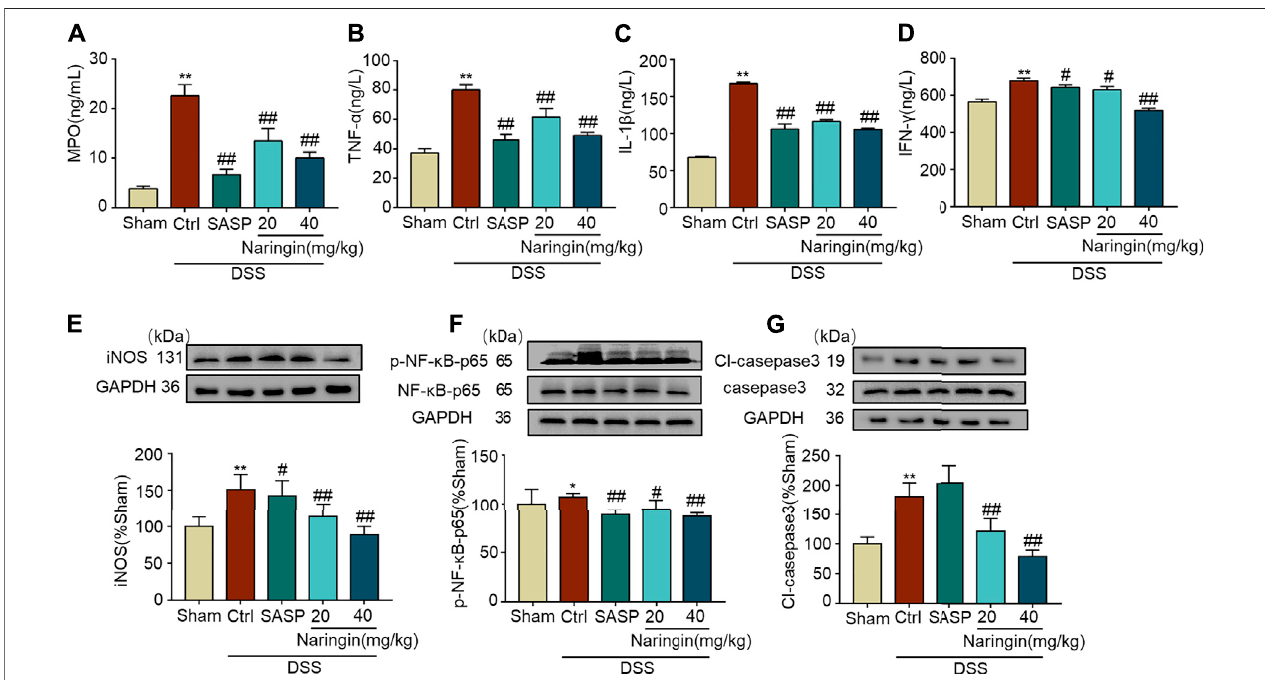
FIGURE3| Effectsofnaringinonin fl ammationandapoptosisinDSS-colitis.Expressionlevelsofthecoloniccytokines (A) MPO, (B) TNF- α , (C) IL-1 β ,and (D) IFN- γ were determined by ELISA. Western blotting analysis of in fl ammation-related proteins (E) iNOS, (F) p-NF- κ B-p65 (calculated as p-NF- κ B-p65/NF- κ B-p65); apoptosis- relatedprotein (G) cl-caspase3,calculatedascl-caspase3/caspase3.Dataareexpressedasmean ± SD.Valuesintheshamgrouparesetto100%andothervaluesare givenrelativetothoseintheshamgroup,* p < 0.05,** p < 0.01comparedwithshamgroup; # p < 0.05, ## p < 0.01comparedwithDSS-colitisgroup; n (cid:2) 3samplesin western blotting experiments; n (cid:2) 6 samples for other experiments. These blots are cropped, and the full-length blots are presented is in the Supplementary Figures S2 – S9 .